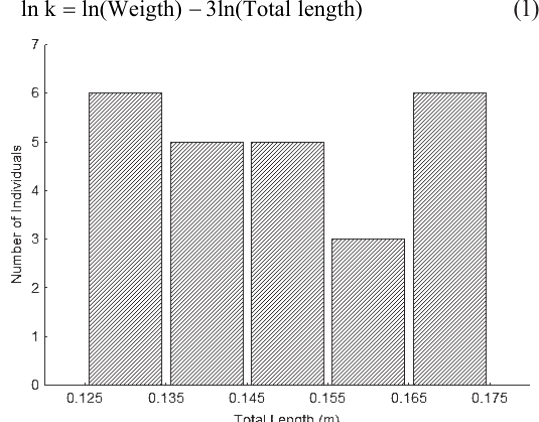
Fig. 1. Number of tested fish per total length classes used to determine critical